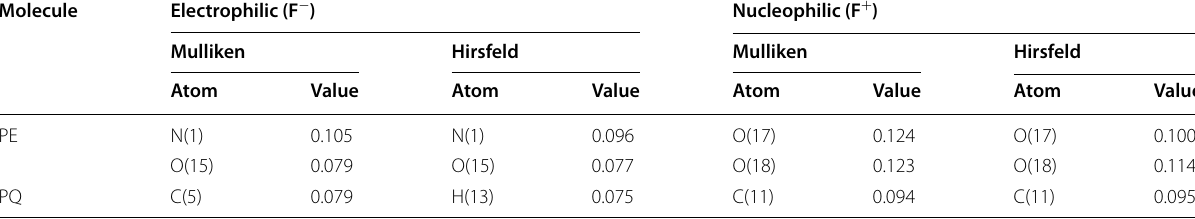
Table 5 Calculated Fukui indices for the studied inhibitor molecules